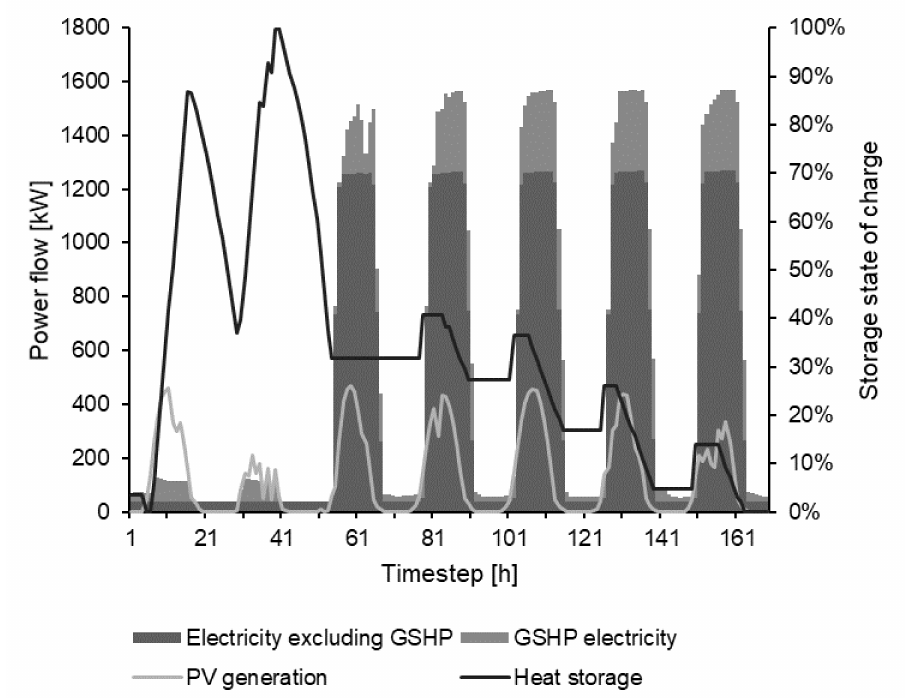
Figure 4. Demonstration of power-to-heat and storage interoperation from the simulated data. The graph shows one-hour timesteps for the first week (Monday–Friday) of July, including the leading weekend